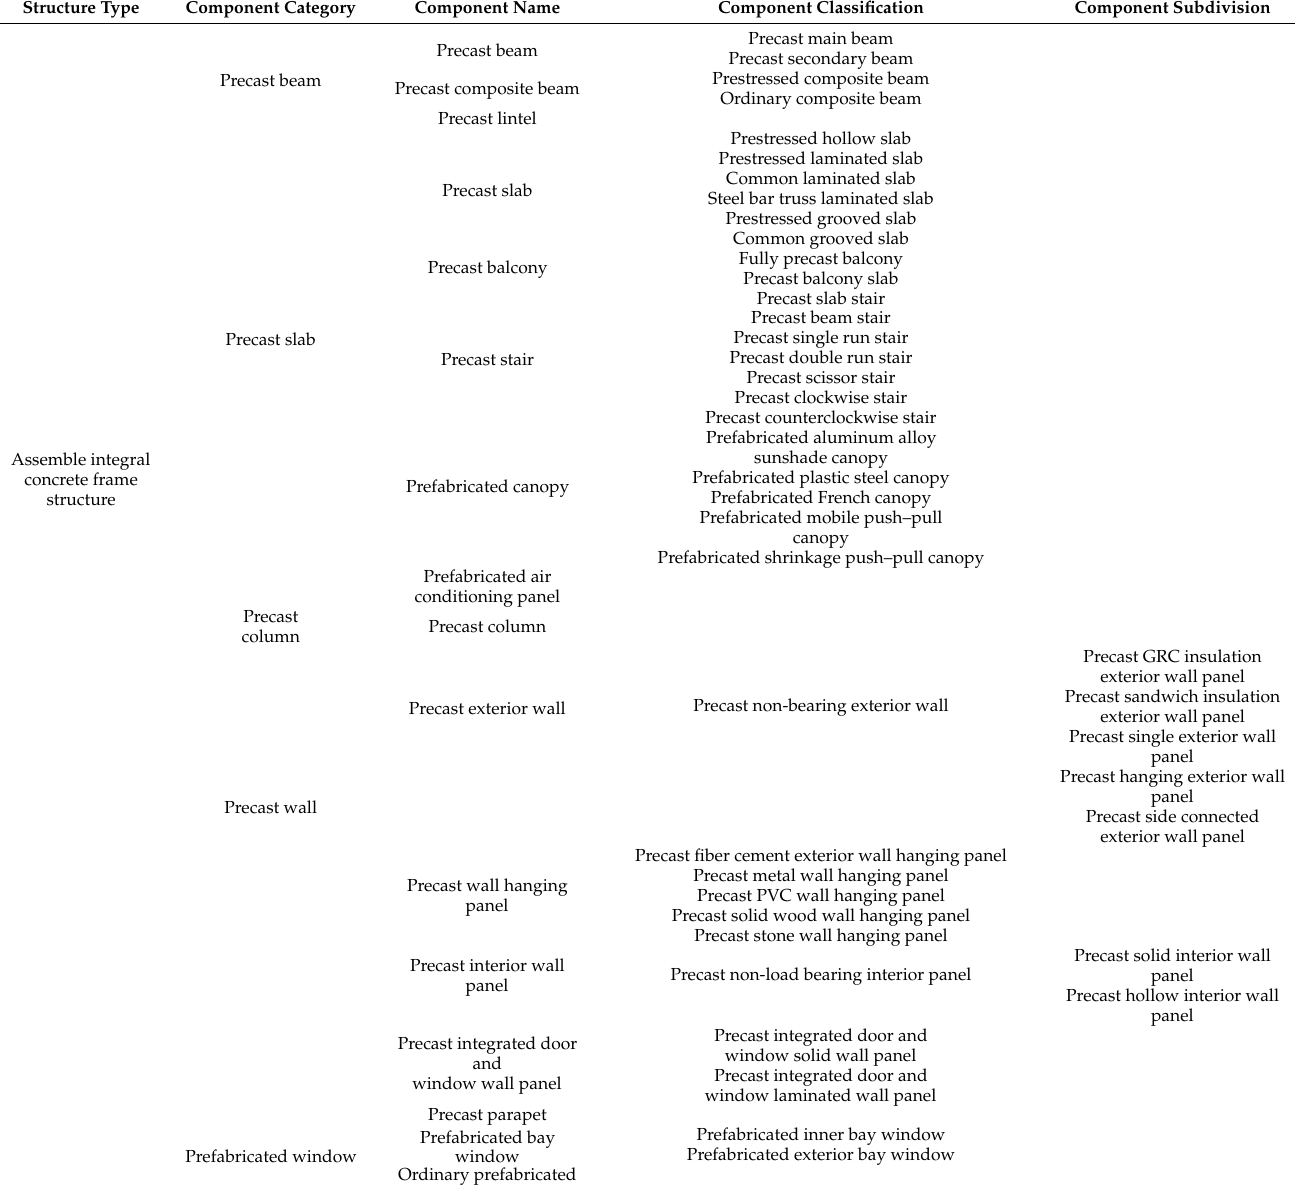
Table 1. Information classification of precast integrated concrete frame